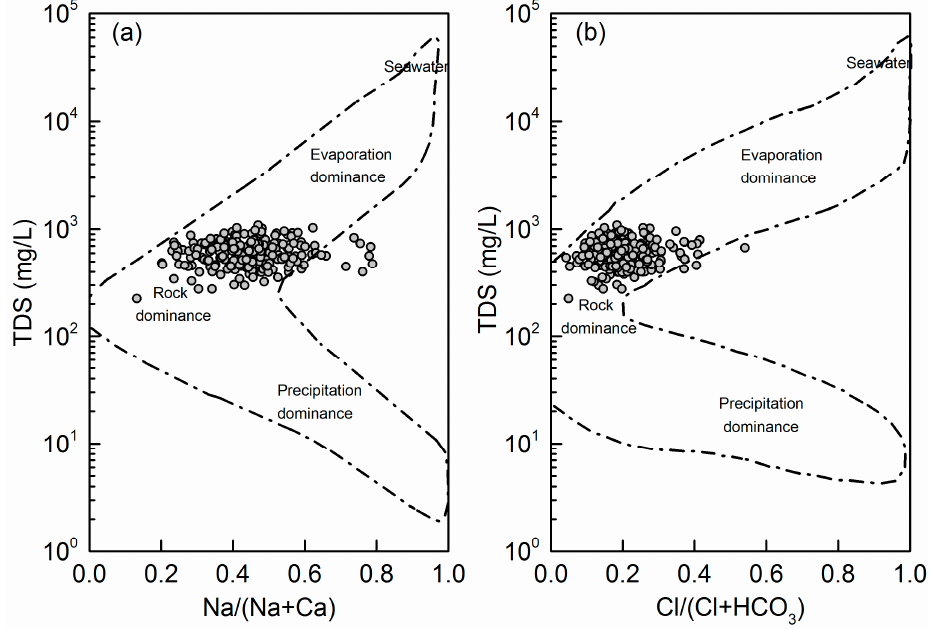
Figure 3. Gibbs diagrams for the shallow groundwater in the Su-Xi-Chang region.